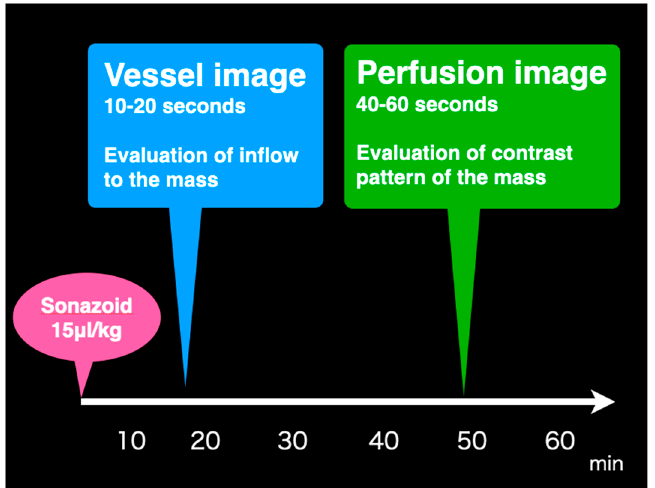
Figure 4. A schema rendering the time schedule of CH-EUS. The presence or absence of blood flow in the nodule was evaluated for 20 s immediately after administration (vessel image), and the degree of contrast was evaluated during the period between 40 and 60 s after administration (perfusion image). CH-EUS, contrast-enhanced harmonic endoscopic ultrasound.